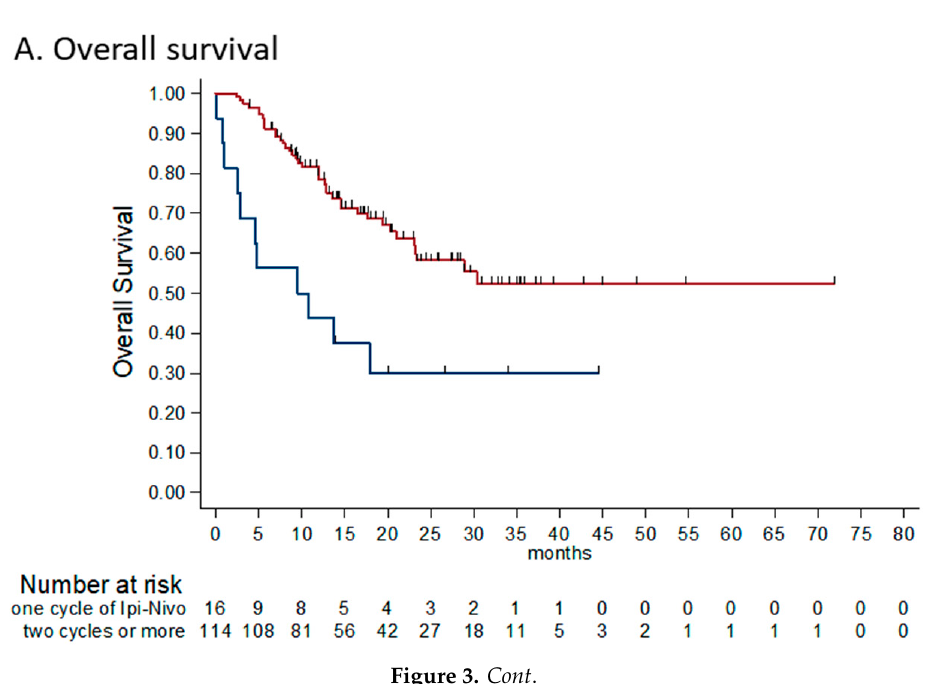
Figure 3. Kaplan-Meier survival estimates according to number of combinations received in the induction phase (stopped for toxicity only). ( A ) OS according to number of ipilimumab and nivolumab combinations received. HR for death 0.35 (95% CI 0.18–0.68, p = 0.002) for patients receiving two or more cycles, compared to patients who received only one cycle. Median OS were NR and 9.5 m, respectively. ( B ) PFS according to number of ipilimumab and nivolumab combinations received. HR for progression or death 0.58 (95% CI 0.31–1.07, p = 0.085) for patients receiving two or more cycles, compared to patients who received only one cycle. OS—overall survival, PFS— progression free survival, HR—hazard ratio. 3.4.6. BRAF Status Considering patients with a known BRAF status who received ipilimumab + nivolumab in the first-line setting (95 patients, 60%), more than a third ( n = 37, 39%) had a BRAF V600 mutation and 58 (61%) had BRAF wild type (WT). Response rate for ipilimumab and nivolumab given the first line setting was significantly higher for BRAF mutant patients compared to BRAF WT (70% vs. 57%, p = 0.015). Accordingly, there was a borderline significant favorable survival outcome for BRAF mutant patients treated with ipilimumab and nivolumab in the first line setting, compared to BRAF WT; HR for OS was 0.5 (95% CI 0.22–1.13, p = 0.096) and HR for PFS was 0.53 (95% CI 0.27–1.03, p = 0.061). 3.4.7. Toxicity and Steroid Treatment